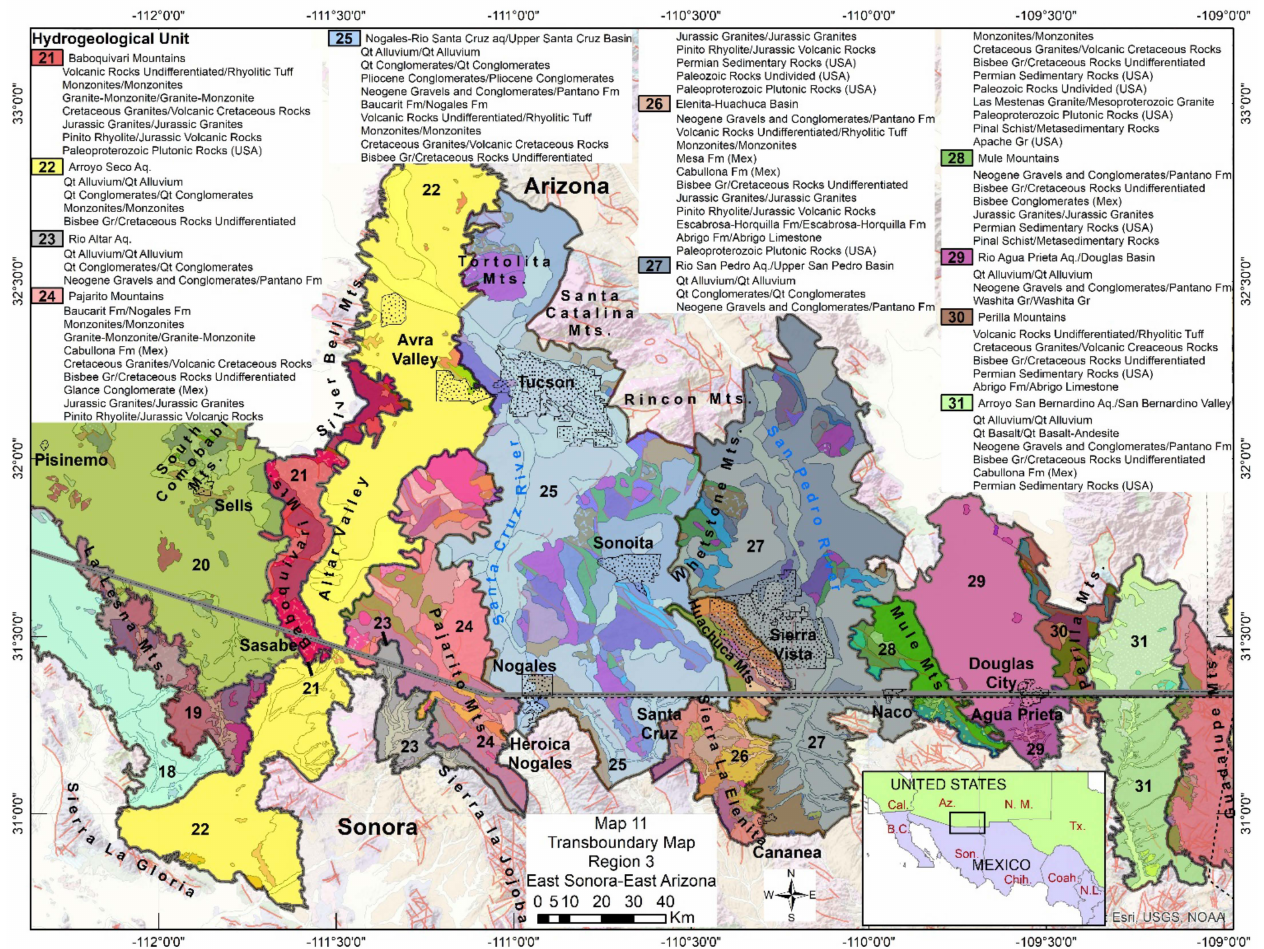
Figure 11. Transboundary map, East Sonora—East